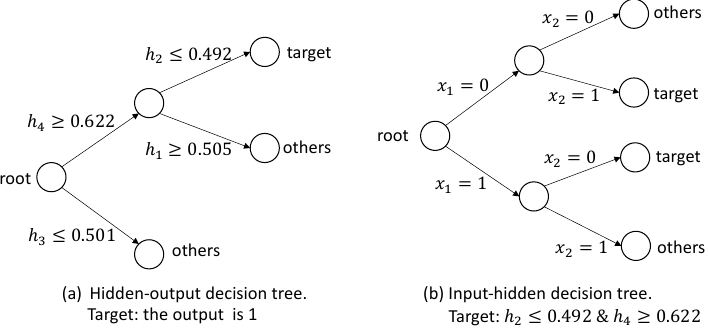
Figure 10. The hidden-output decision tree for the target y = 1 in the “XOR” data set.